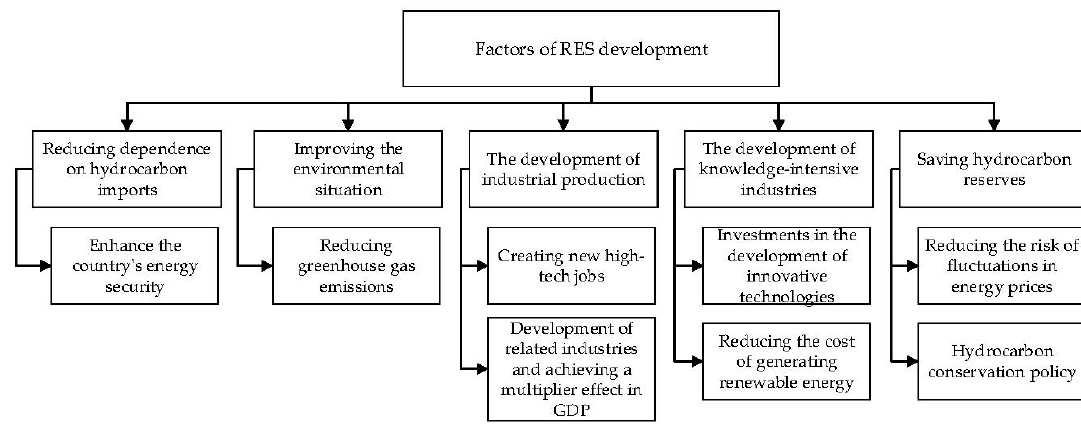
Figure 4. Factors renewable energy development in the world.